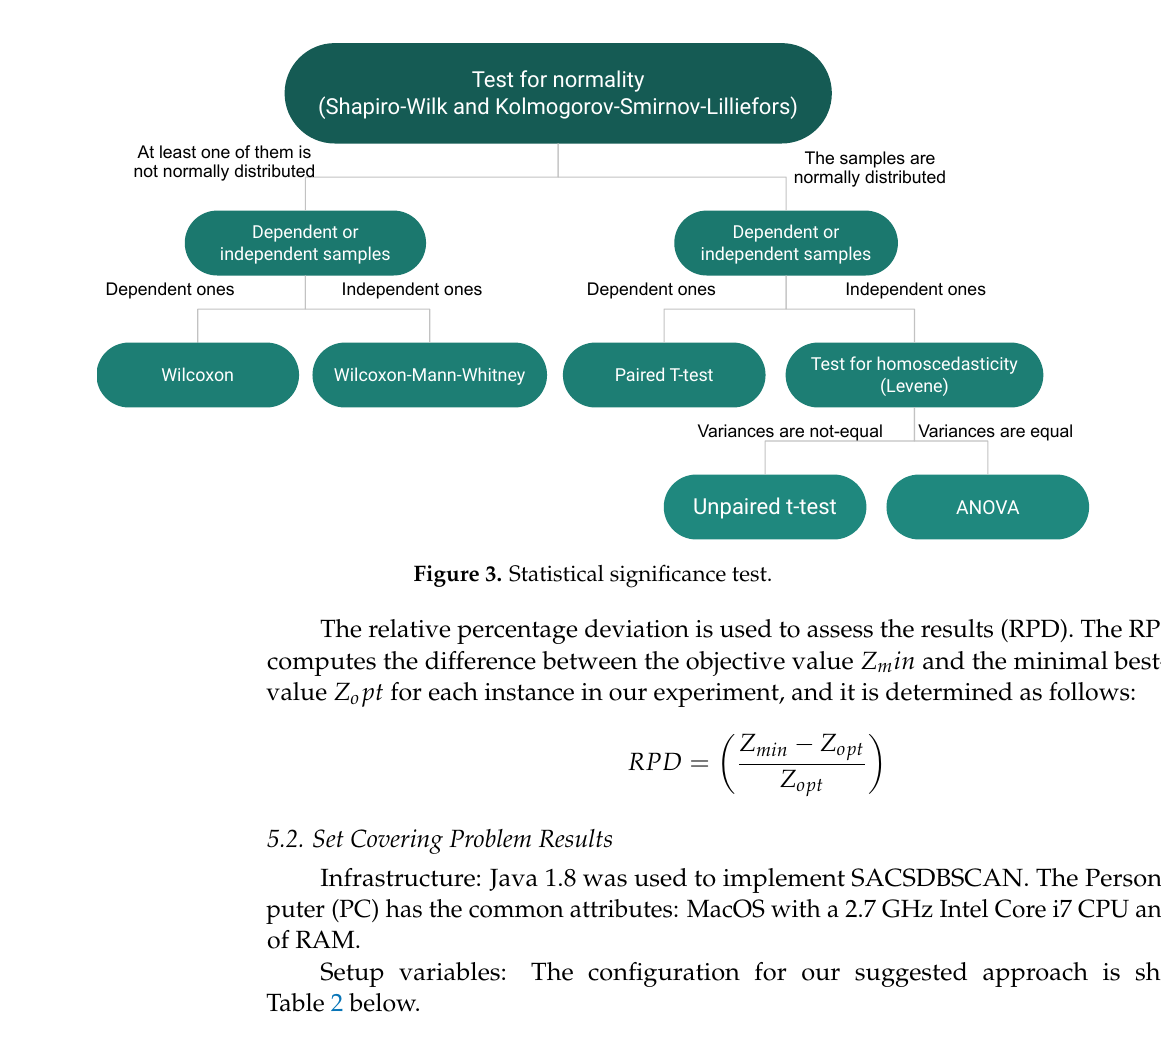
Table 2. SACSDBSCAN Parameters for